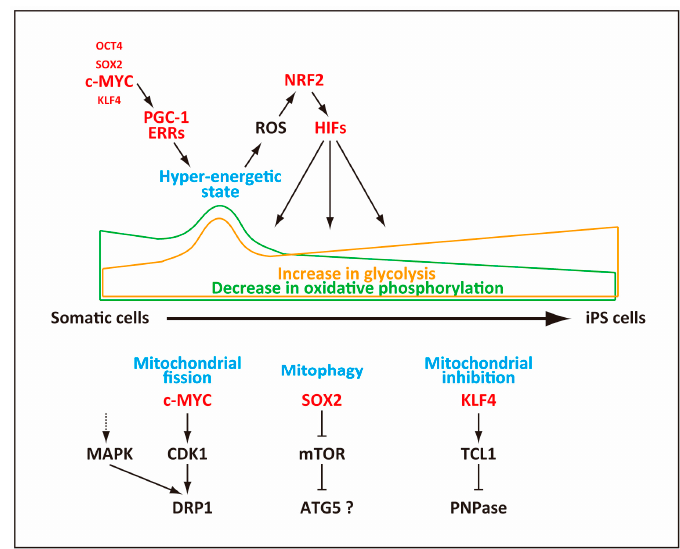
Figure 2. Mechanisms of mitochondrial changes during reprogramming. Mitochondria contribute to the hyper-energetic metabolism that generates reactive oxygen species (ROS) at an early stage or reprogramming. The generated ROS serve as a signal to activate nuclear factor (erythroid-derived 2)-like-2 (NRF2), which then induces HIFs. Mitochondria also undergo fission, autophagy (mitophagy) as well as functional inhibition, ultimately becoming less active in producing ATP.